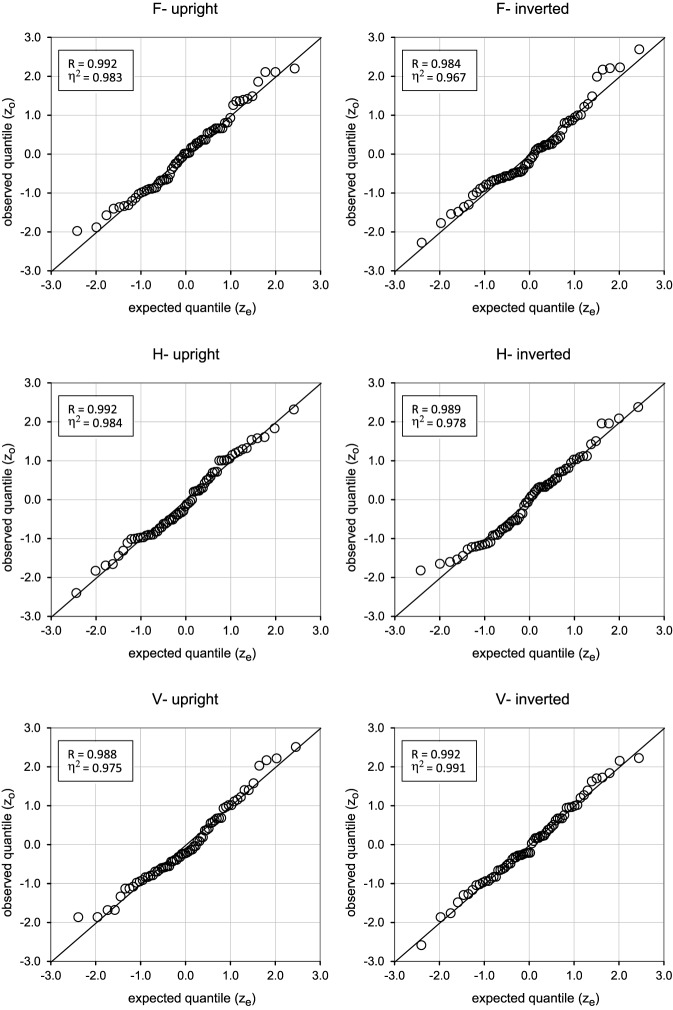
Quantile–Quantile scatterplots (q–q plots) of the standardized within-cell residuals for the six experimental conditions. The straight line is the angle bisector, zo = ze. The figure legends show the Pearson correlation R of zo and ze, and the ratio of explained variance for the identity of observed and expected z-scores, η2.